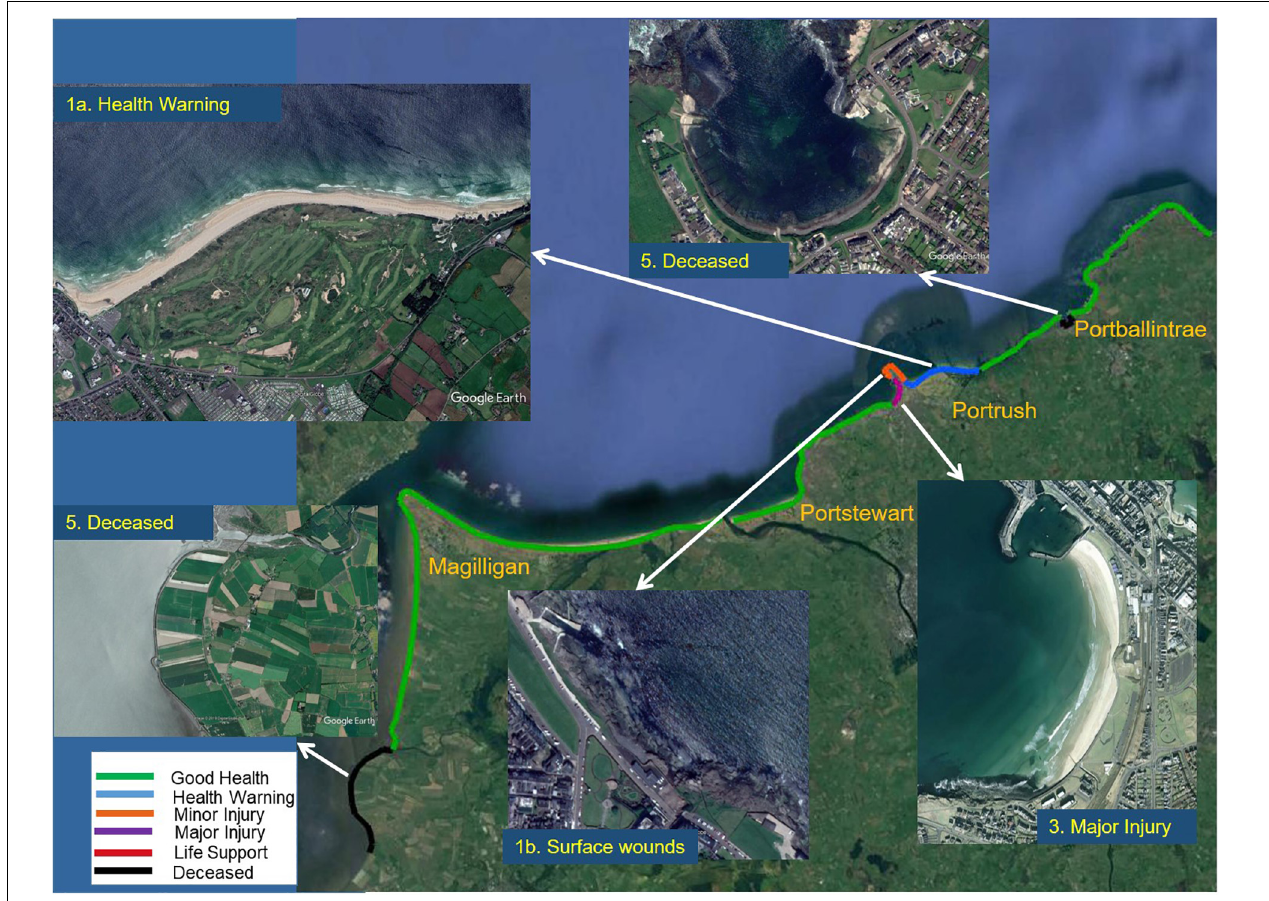
FIGURE 2 | Shoreline Health assessment of a section of the north coast of Northern Ireland. For description see text. Main image and insets from Google Earth. Data (Main Image): SIO, NOAA, U.S. Navy, and GEBCO. Data (Insets) 2019